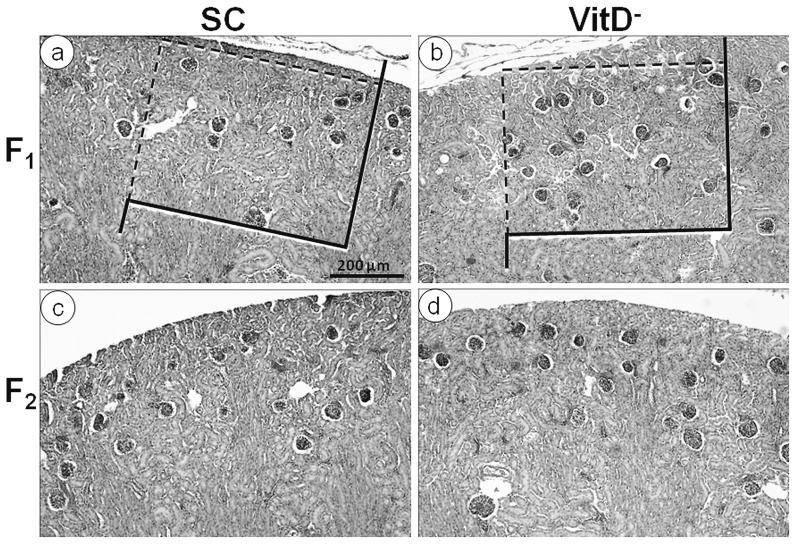
Photomicrographs of developing kidneys from offspring at 10 days of age.Hematoxylin and eosin stain, same magnification in all pictures. (a) SC offspring and (b) VitD- offspring in the F1 generation; (c) SC offspring and (d) VitD- offspring in the F2 generation. We used the same test frame size over the photomicrographs of the two groups to emphasize that the number of glomeruli was greater in the VitD- group than in the SC group. As observed at birth (Fig. 5). Differences between the SC group (c) and the VitD- group (d) are less marked in the F2 generation.